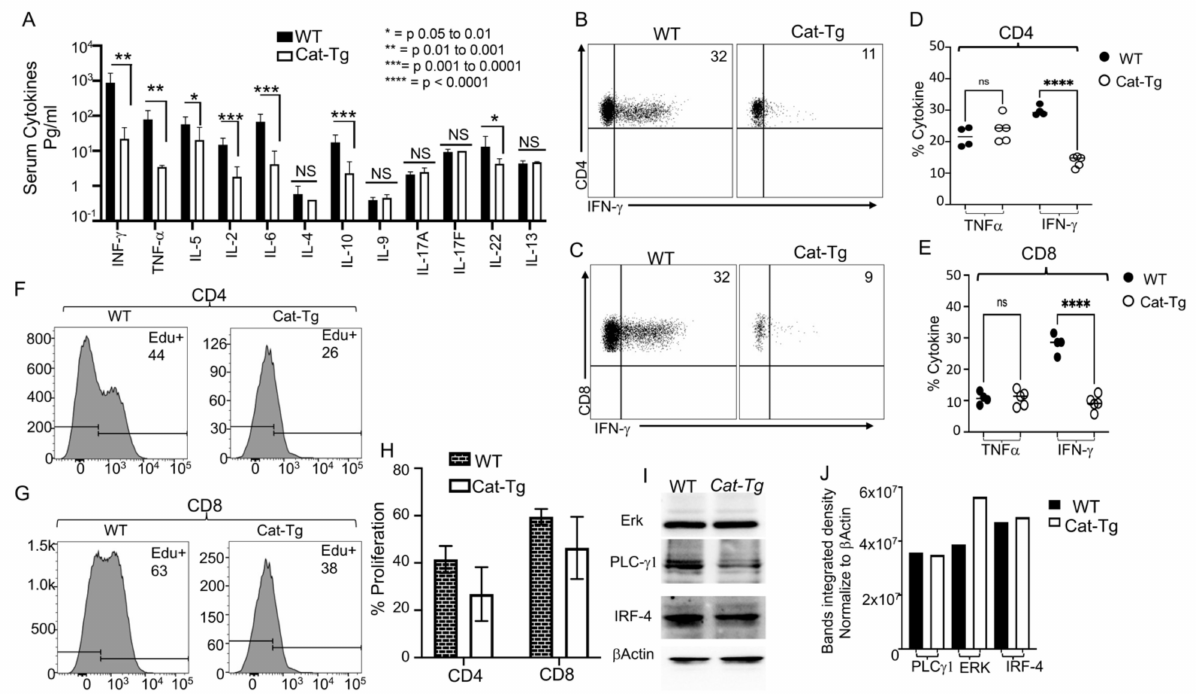
Figure 3. Overexpression of β -Catenin reduces T cell inflammatory cytokine production and proliferation without affecting signaling molecules. ( A ) 1 10 6 purified WT or Cat-Tg CD3 + T cells were transplanted with TCD BM into irradiated BALB/c × mice. On day 7 post-allo-HSCT, recipient BALB/c were euthanized and serum cytokines (IFN- γ , TNF- α , IL-2, IL-5, IL-6, IL-4, IL-10, IL-9, IL17A, IL-17F, IL-22, and IL-13) were determined by multiplex ELISA. ( B , C ) Intracellular IFN- γ and TNF- α expression by donor CD4 ( B ) and CD8 ( C ) T cells after 6 h stimulation with anti-CD3/anti-CD28 and GolgiPlug, as determined by flow cytometry. ( D , E ) Quantified IFN- γ and TNF- α expression for ( B , C ). ( F – H ) Ex vivo proliferation of donor CD4 + or CD8 + T cells from Cat-Tg or WT mice. Lethally irradiated recipient BALB/c mice were transplanted as mentioned above, with either WT or Cat-Tg donor CD3 + T cells. Recipient mice were given EdU in PBS i.p. (25 mg/kg in 100 µ L) on days 5 and 6 post-transplant. At 7 days post-allotransplantation, recipient mice were sacrificed and examined for proliferation by EdU incorporation via flow cytometry. ( I ) Purified CD3 + WT and Cat-Tg T cells were examined for total protein expression of ERK, PLC γ -1, and IRF-4 by Western blot. ( J ) Quantitative analysis from Western blots in (I), using ImageLab software to normalize to β -Actin. Symbol meanings for p values are: ns— p > 0.05; * p *** p 0.001; **** p 0.0001. (For A – G , n = 5 mice per group, for H , I , n = 3 mice used per ≤ ≤